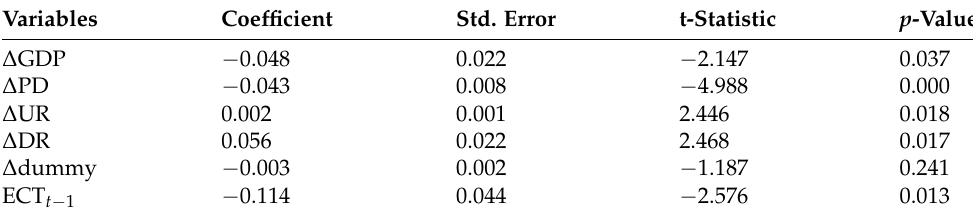
Table A3. Short-run coefficients with break.